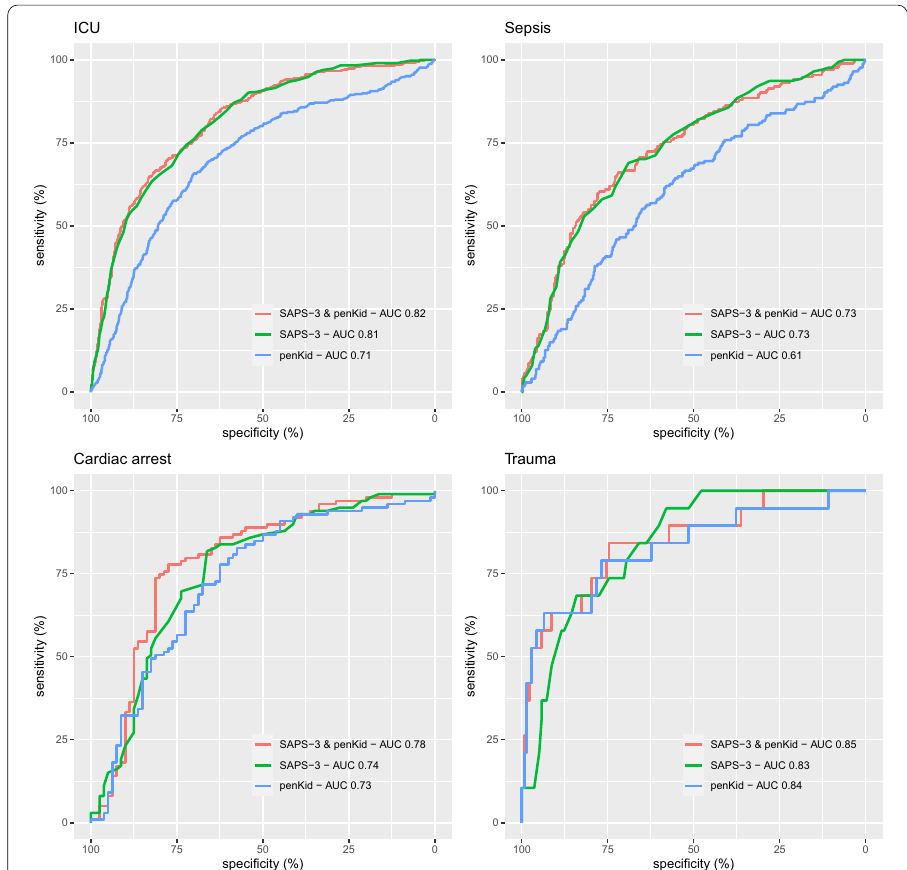
Fig. 2 Receiver operating characteristic (ROC) curves and area under curves (AUC) for logistic regression models of 30-day mortality. ICU: intensive care unit, SAPS-3: simplified acute physiology score III, penKid: proenkephalin A